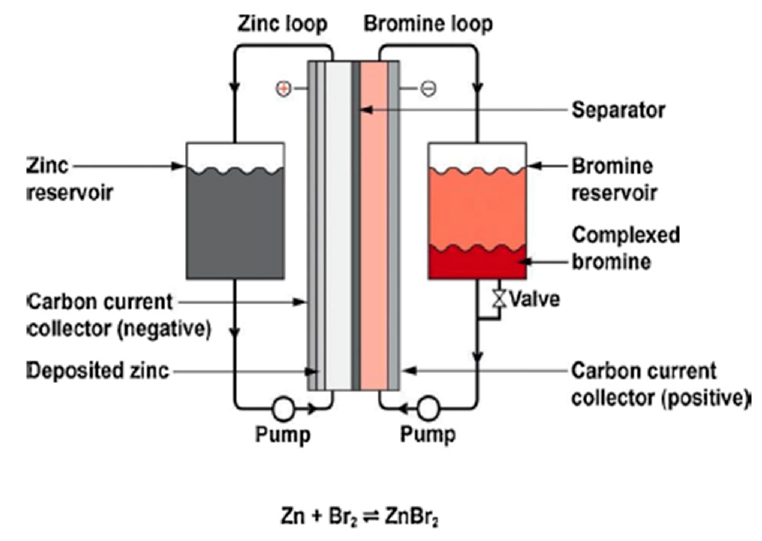
Figure 11. Chemistry and principal components of a zinc–bromine battery.